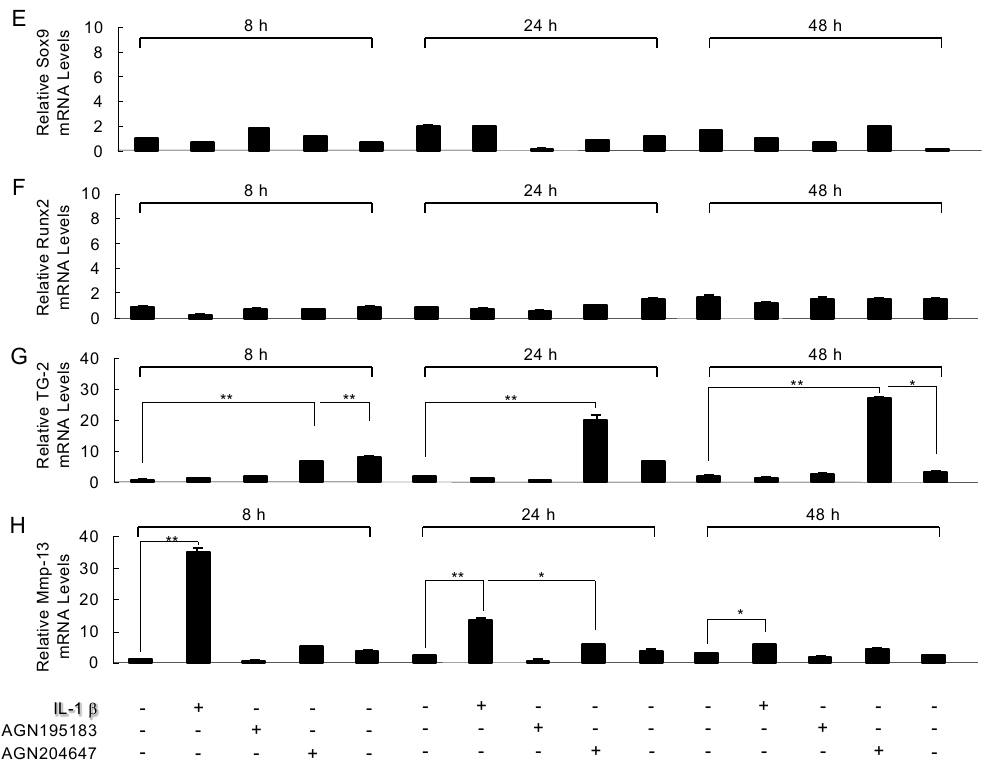
Figure 2. Modulation of the expression of chondrocyte-specific genes’ mRNA by IL-1 β , retinoid receptor